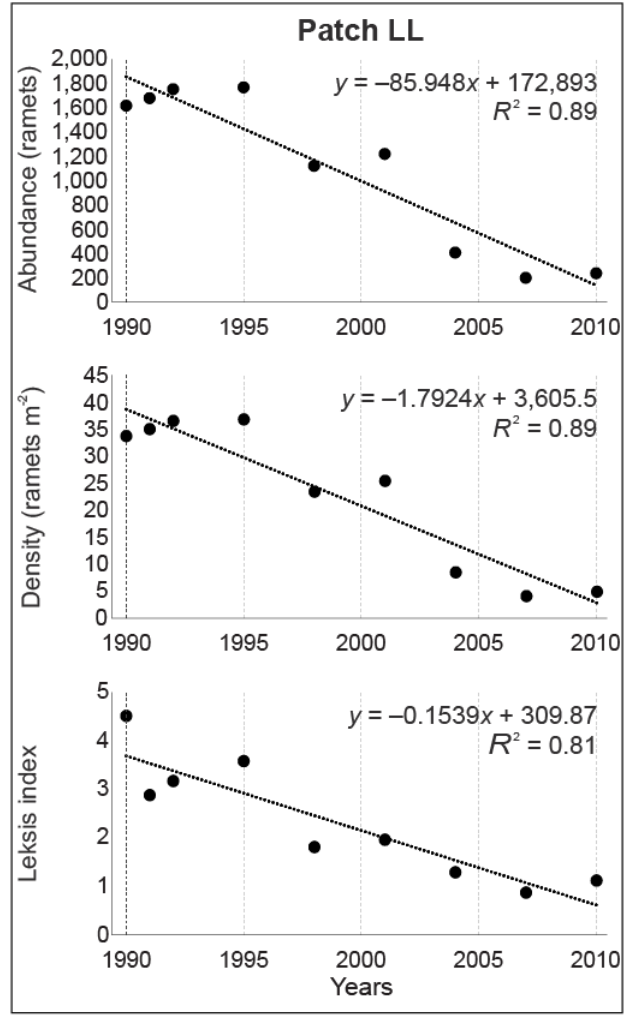
Figure 5 Changes of values and linear regression for abundance, density, and Leksis’ index of the Senecio umbrosus population within patch